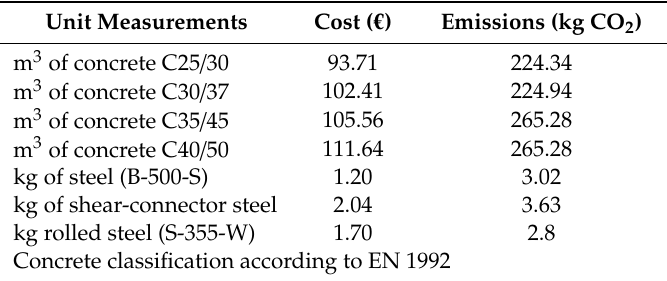
Table 1. Prices and CO 2